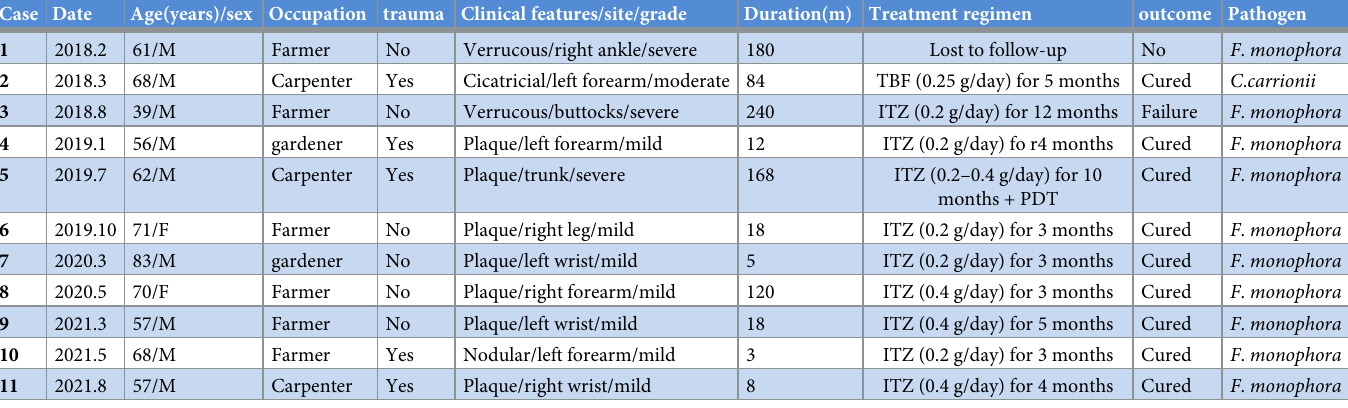
F, female; M, male; ITZ, itraconazole; TBF, terbinafine; m, month; PDT, photodynamic therapy